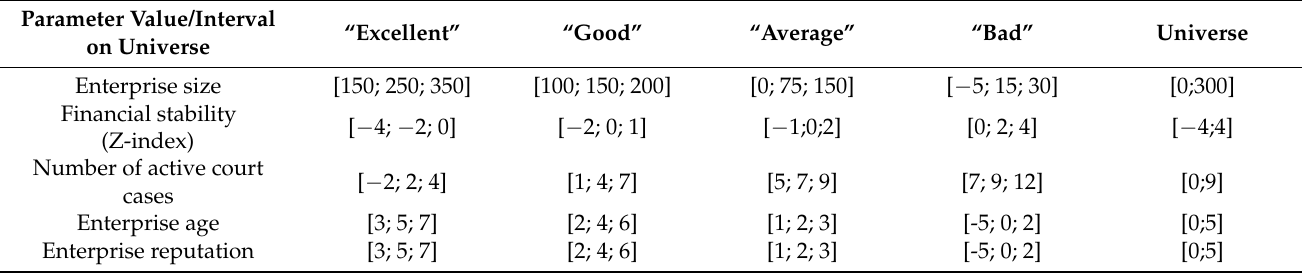
Table 5. Correspondence of a linguistic variable to a value on the universe